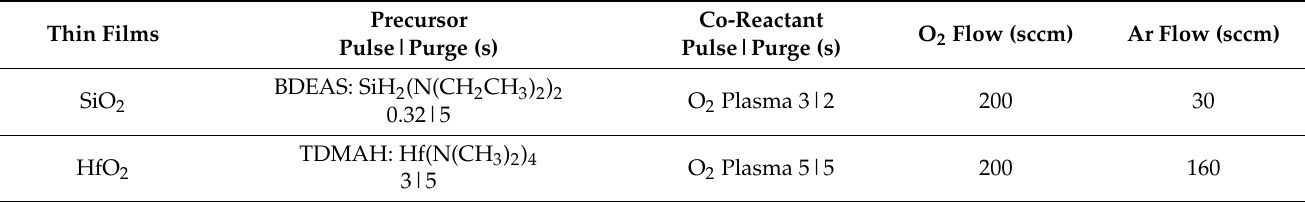
Table 1. PEALD process parameters for SiO 2 :HfO 2 heterostructure films. Thin